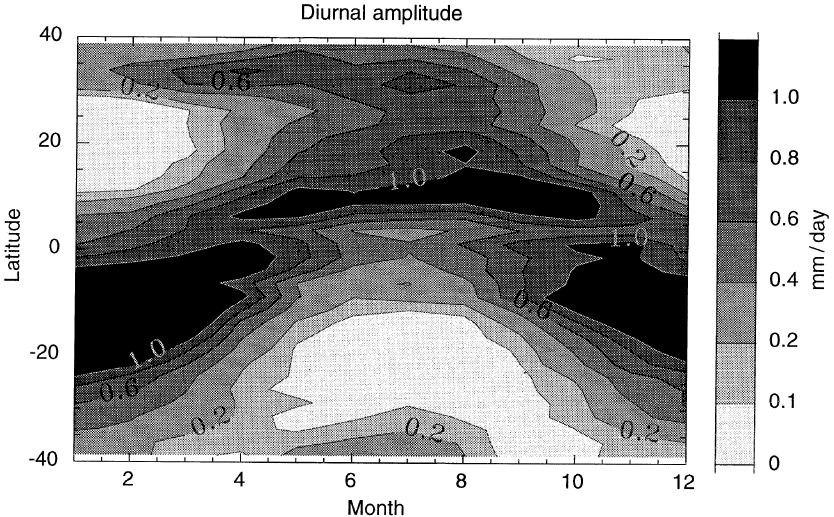
Fig. 5. Contours of the diurnal amplitude of e(cid:128)ective rainfall rate (mm/day) deduced from global cloud imagery data plotted versus month (number) of the year and latitude. These rates are used to specify the monthly variation of the latitude distribu- tion of latent heating in GSWM